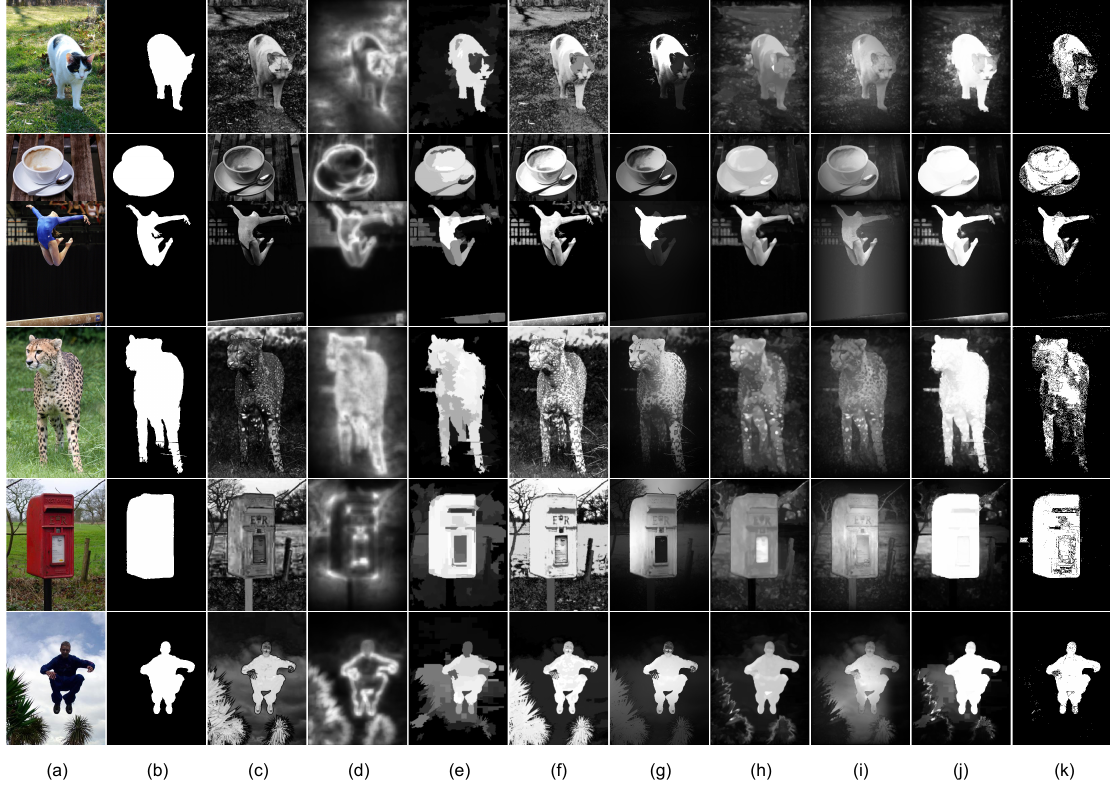
Figure 5. Saliency maps of individual and aggregation methods. The binary outcome obtained from our approach is presented: ( a ) Input image; ( b ) Ground truth; ( c ) FT; ( d ) CA; ( e ) RC; ( f ) HC; ( g ) SF; ( h ) MBS; ( i ) MDC; ( j ) PW; and ( k )